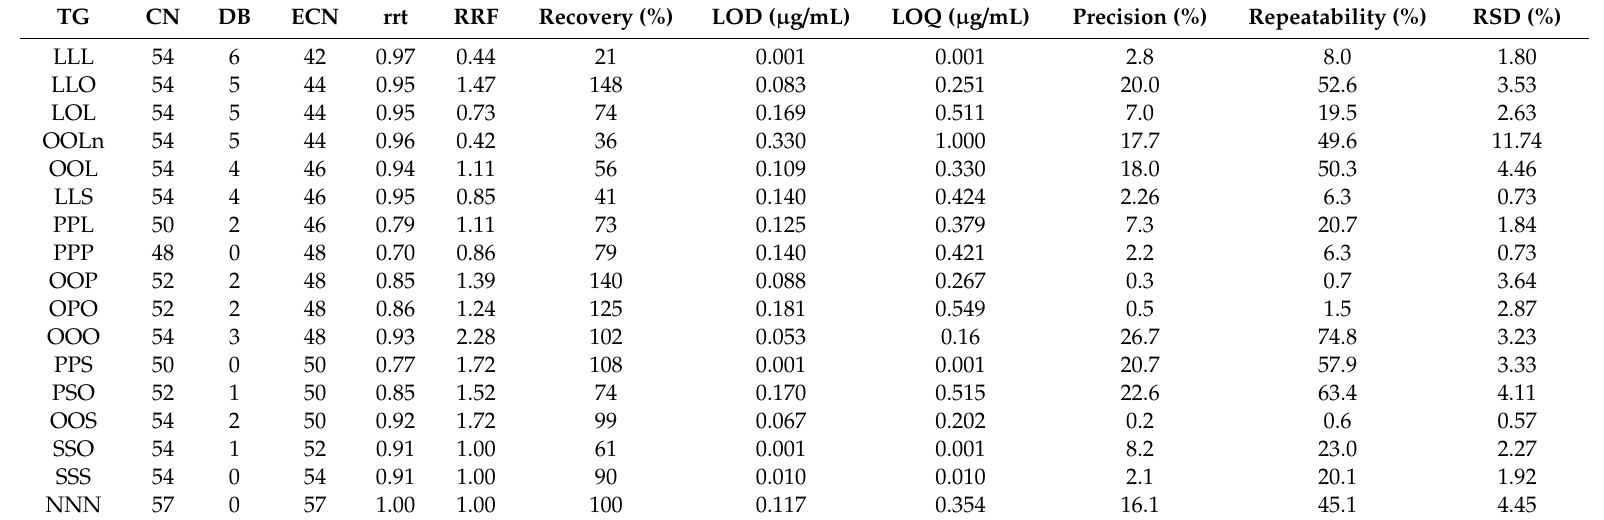
Table 1. Chemical and validation parameters used for the analysis of TG by GC-FID